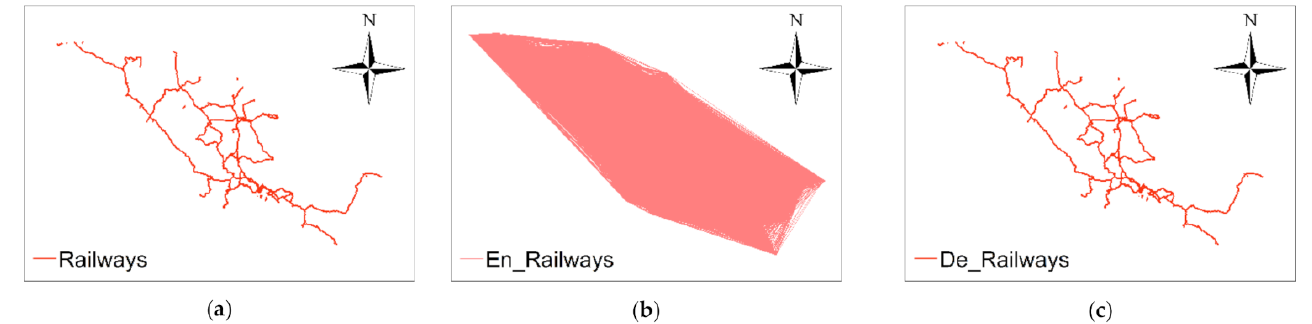
Figure 7. The map with one layer (railways). ( a ) The original map; ( b ) the cipher map; ( c ) the decrypted map.